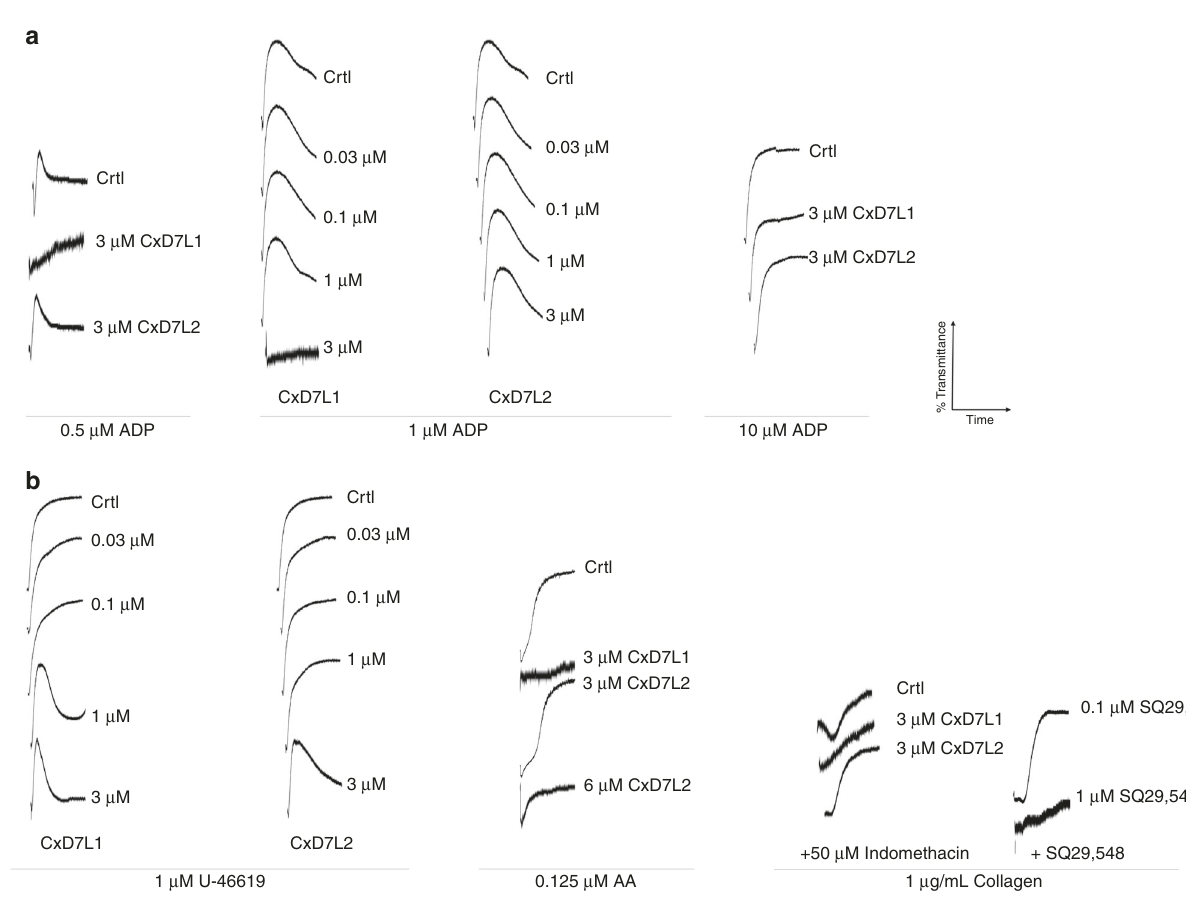
Fig. 7 Effect of CxD7 proteins on platelet aggregation induced by secondary mediators. Prior to the addition of the agonist, platelet-rich human plasma was incubated for 1 min either with PBS (Crtl) or with the recombinant proteins, or SQ29,548 at the concentrations shown. Aggregometer traces were measured at 37 °C from stirred platelets suspensions on a Chrono-Log platelet aggregometer model 700 for 6 min. An increase of light transmittance over time indicates platelet aggregation. a Platelet aggregation traces using different concentrations of ADP (0.5, 1, and 10 µ M) as aggregation agonist. b Platelet aggregation traces using 1 µ M U-46619, 0.125 µ M arachidonic acid (AA), or low collagen concentration (1 µ g/mL). Graphs are representative of two measurements. Source data are provided as a Source Data fi